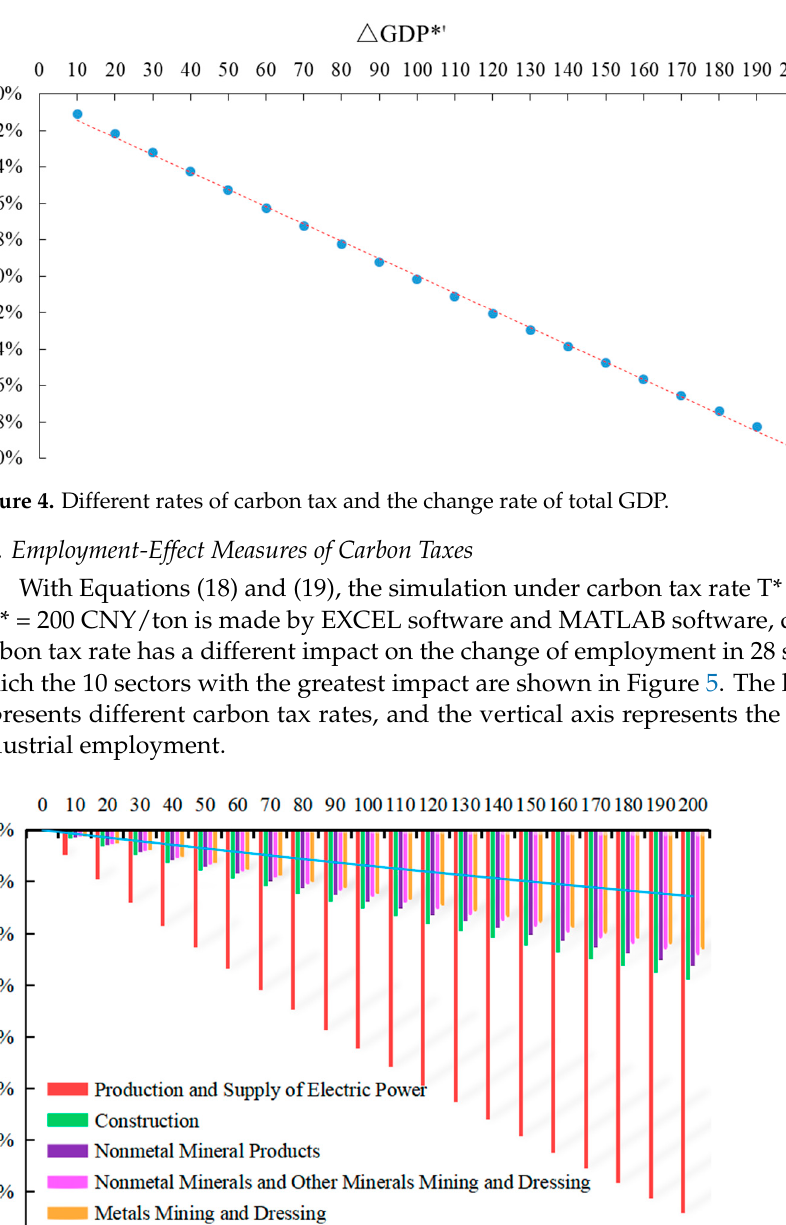
Figure 4. Different rates of carbon tax and the change rate of total GDP.